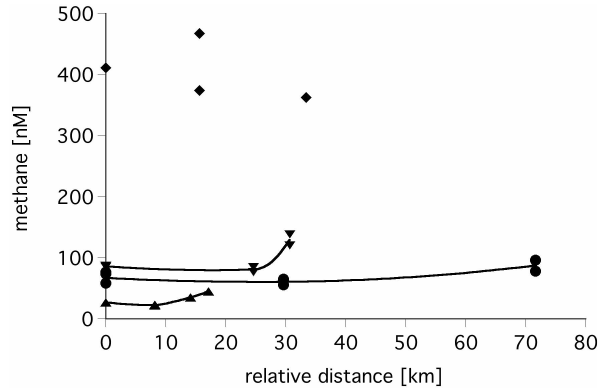
Fig. 7. Methane concentrations in the Olenekskaya Channel 2010 (diamonds), Trofimovskaya Channel 2008 (upward triangle) and 2010 (downward triangle) and the Bykovskaya Channel (circles) plotted versus flow direction and distances from the first station (set as 0km).